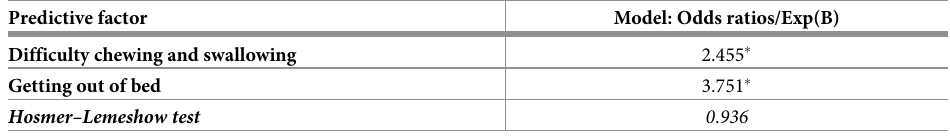
Table 3. Factors associated with presence of a